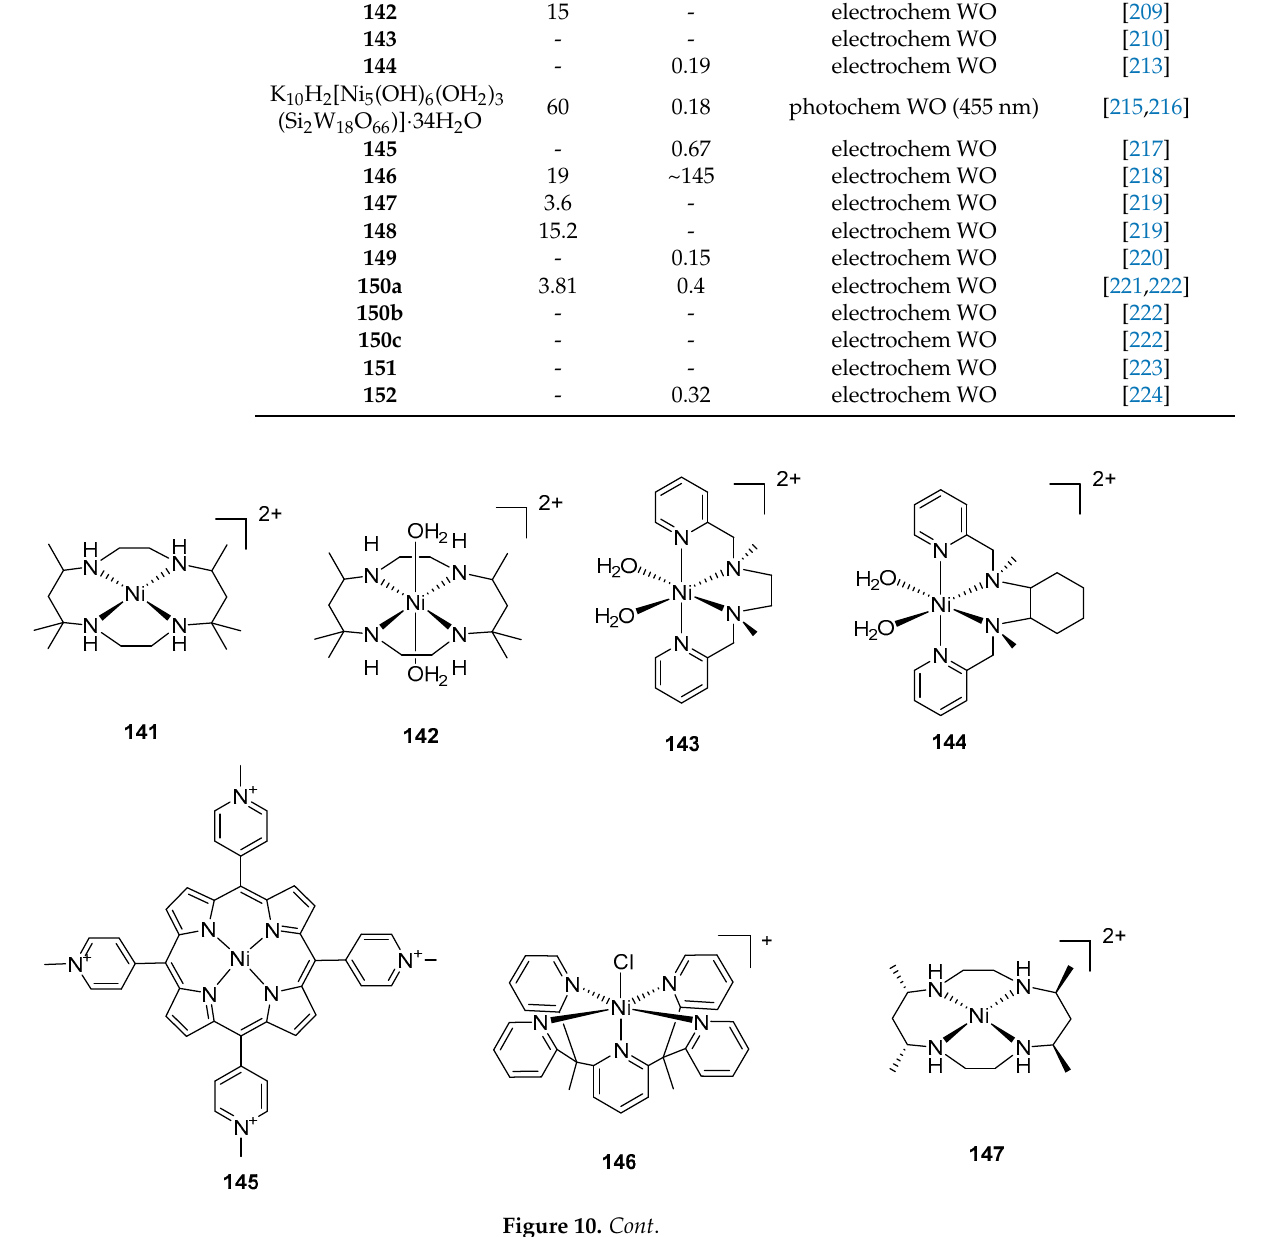
Figure 10. Selected cobalt complexes 141–152 for water oxidation: [Ni( meso -L)] 2+ ( 141 , L = 5,5,7,12,12,14 hexamethyl- 1,4,8,11-tetraazacyclotetradecane) [209]; [Ni( meso -L)(H 2 O) 2 ] 2+ ( 142 , L = 5,5,7,12,12,14 hexamethyl-1,4,8,11-tetraazacyclo- tetradecane) [209]; [NiL(H 2 O) 2 ] 2+ , ( 143 , L = N,N’ -dimethyl- N,N’ -bis(pyridin-2-ylmethyl)-1,2-diaminoethane) [210]; [Ni(mcp)(H 2 O) 2 ] 2+